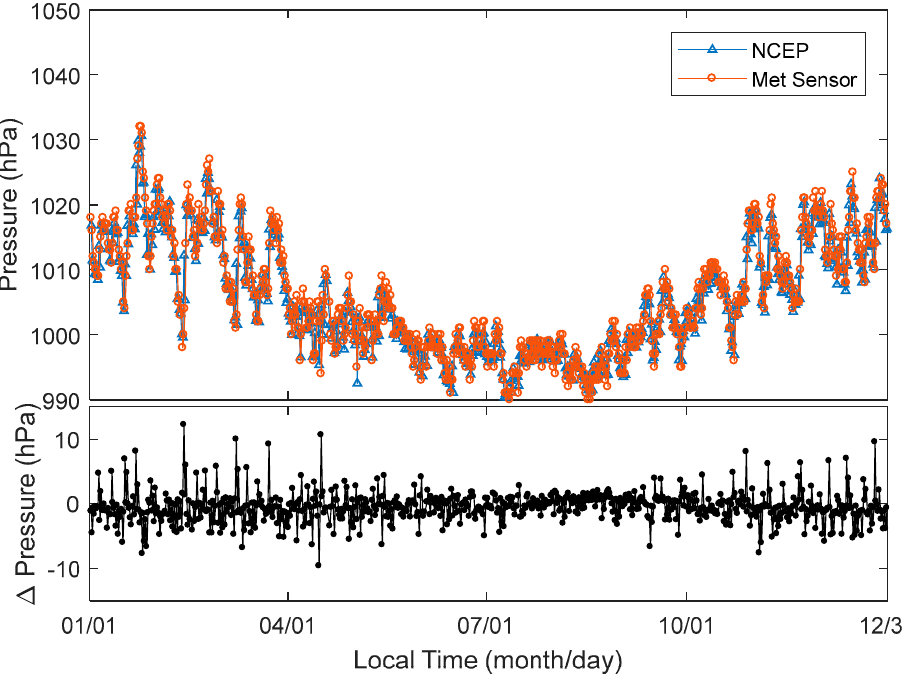
Figure A4. The atmospheric pressure time series from NCEP and radiosonde at GPS Quzh station and QUZO radiosonde station, respectively.